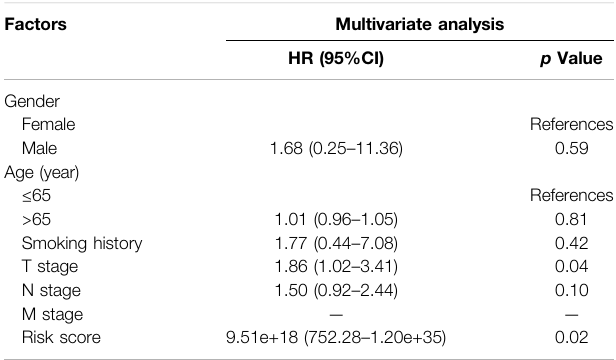
TABLE 2 | Multivariate Analysis of GEO